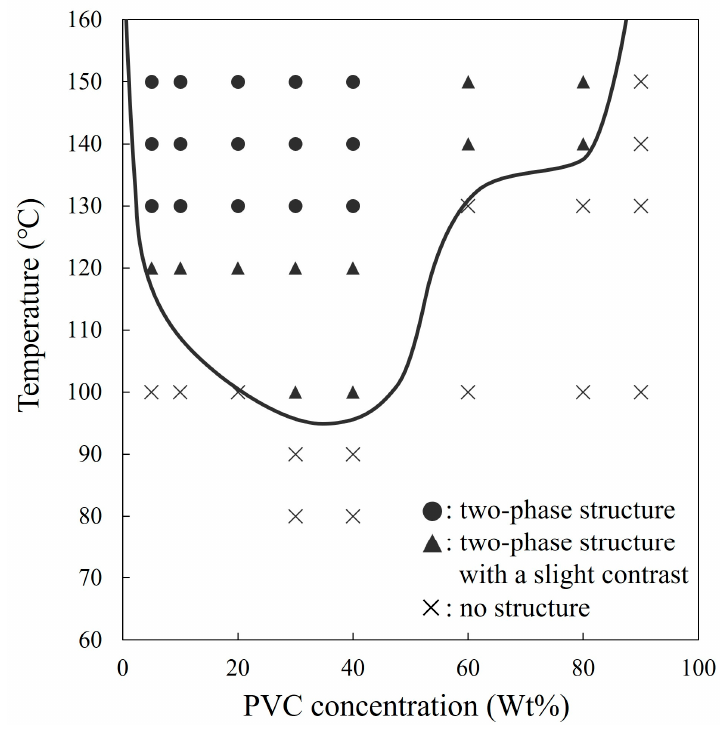
Figure 2. Phase diagram of NBR/PVC blends.